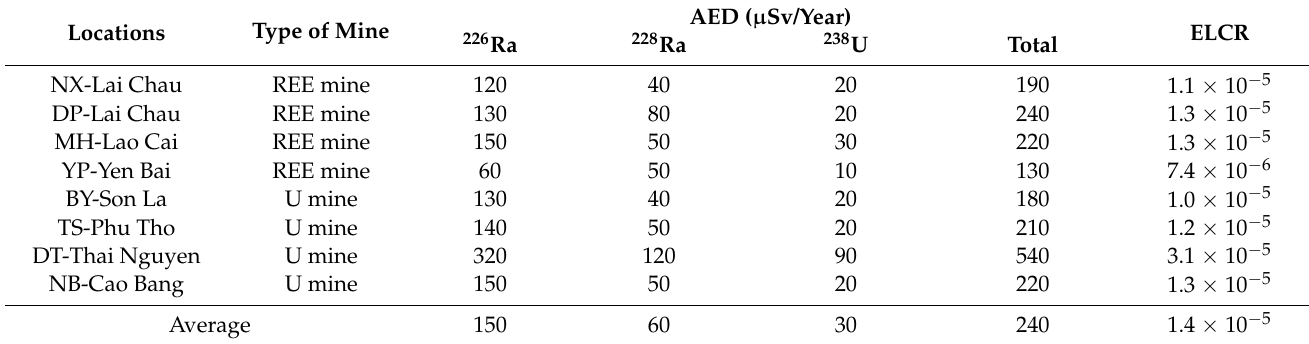
Table 3. Radiation hazard indices for well water samples in northern